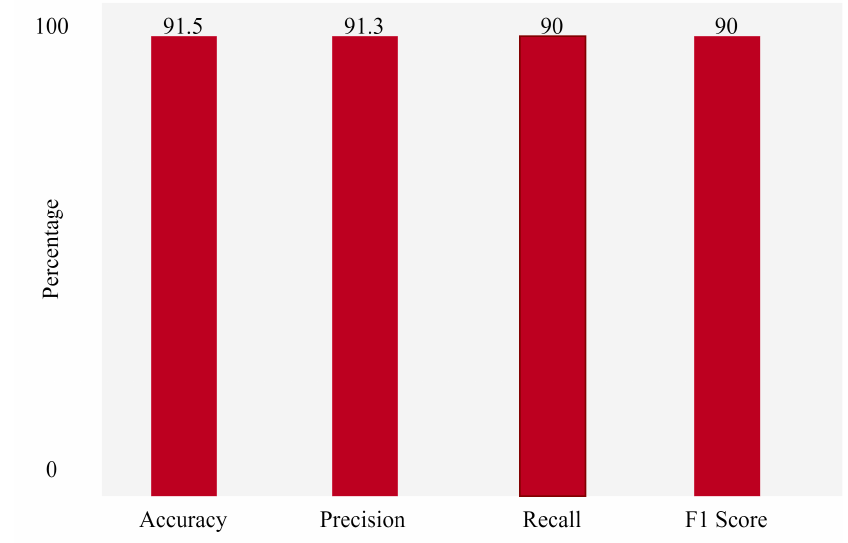
Figure 8. Evaluation of ENN on UNSW-NB15 without k-Means Clustering.